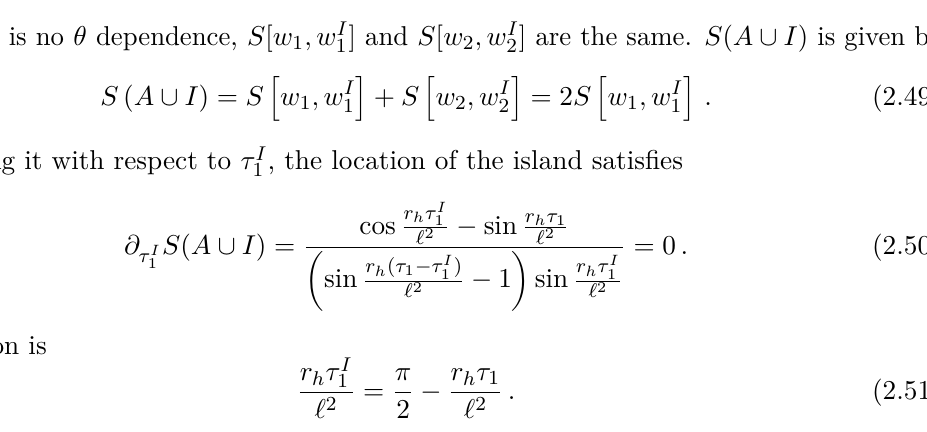
Figure 9 . Conformal maps from the brane and bath to a whole complex plane for island